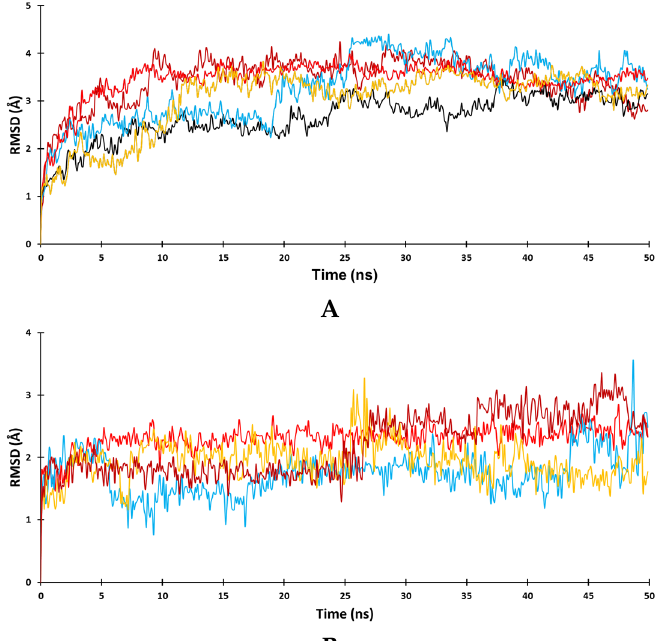
Figure 7. MD simulations of hits targeting the MraY AA binding site. ( A ) RMSD measured on protein backbone atoms for apo MraY AA (black), MraY AA /carbacaprazamycin complex (red), MraY AA / 13 complex (blue), MraY AA /( S , S )- 3a complex (orange) and MraY AA /( R , R )- 3b complex (brown). ( B ) RMSD measured on ligands atoms for carbacaprazamycin (red), 13 (blue), ( S , S )- 3a (orange) and ( R , R )- 3b (brown).